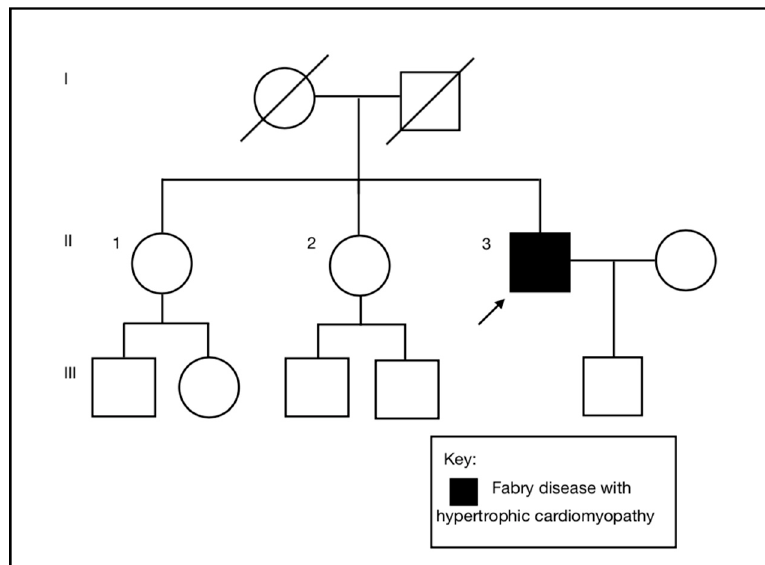
Figure 1. Family pedigree.